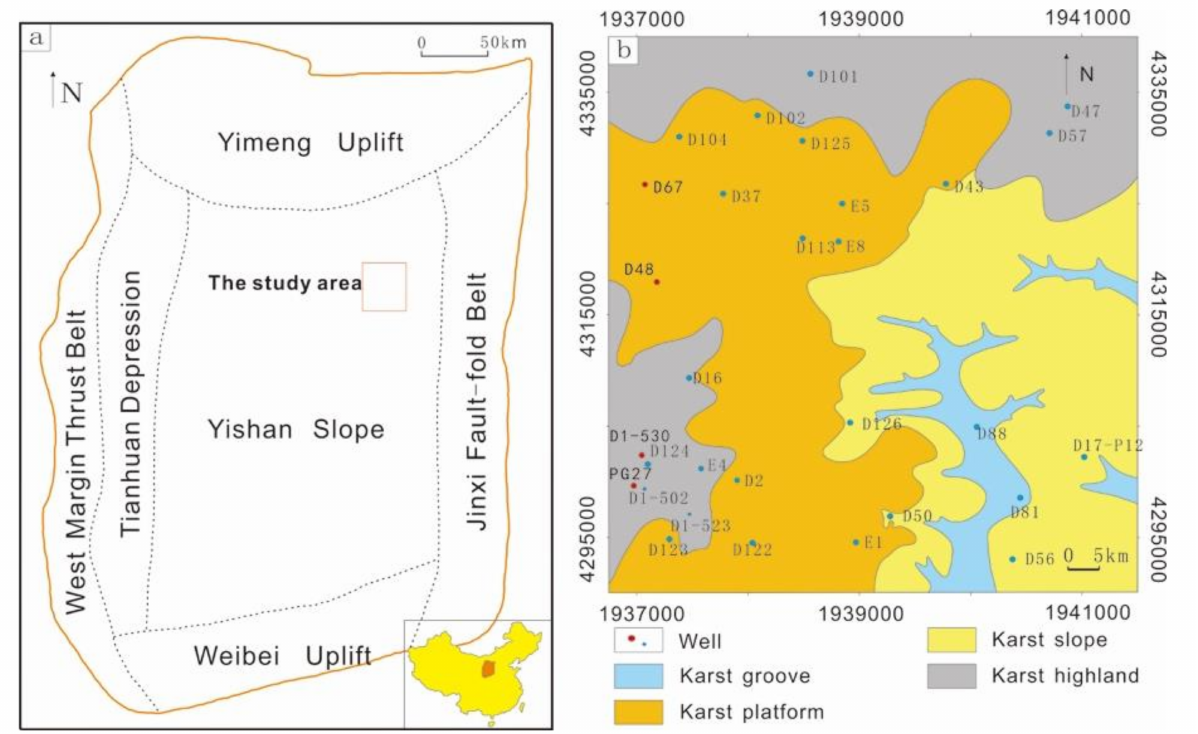
Figure 1. Location of the study area and distribution of wells at the Ordovician Majiagou Formation in the Daniudi area, Ordos Basin: ( a ) location and structural division of the Ordos Basin; ( b ) well location and paleokarst landform in Daniudi Gas